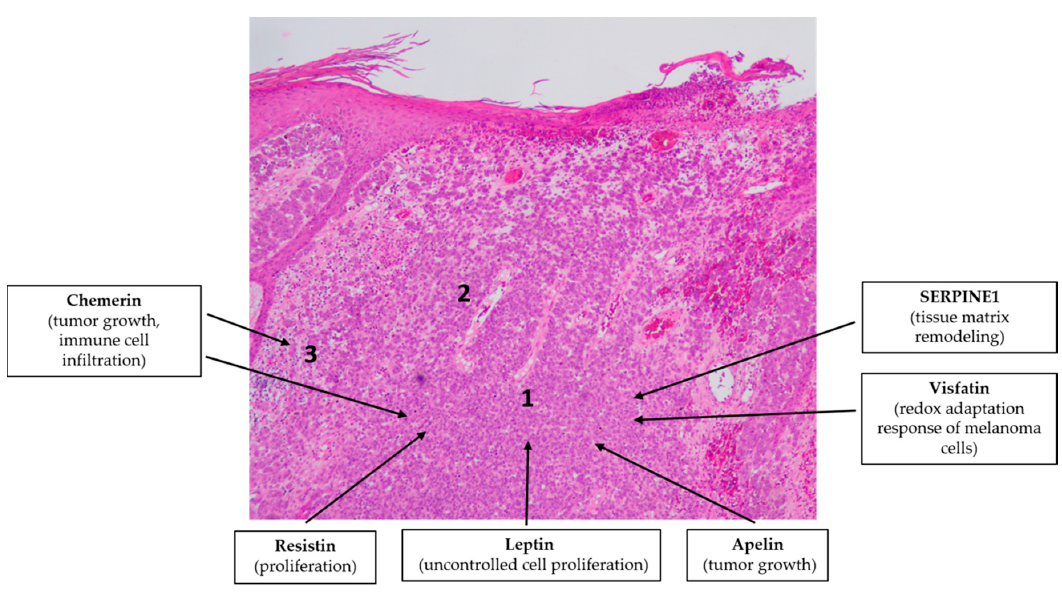
Figure 6. Adipokines might be involved in the pathogenesis of malignant melanoma. Note the simplified characteristic histopathological findings in melanoma: invasion of the malignant cells (1), increased vascularization (2) and immune cell infiltration (3). Hematoxylin eosin staining; original magnification: 50×.